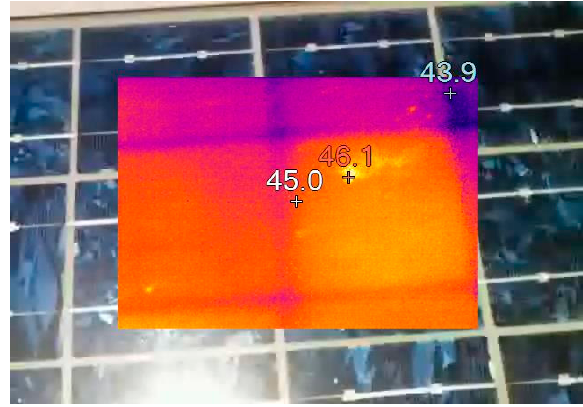
Figure 3. IR thermal image of a cell.